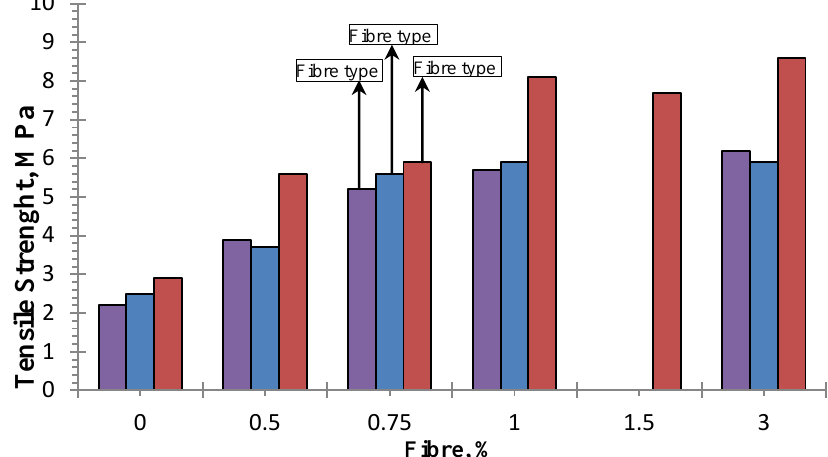
Figure 5. Tensile strength versus type of PP fibers [18]. Reprinted with permission from publisher (2020) [18].